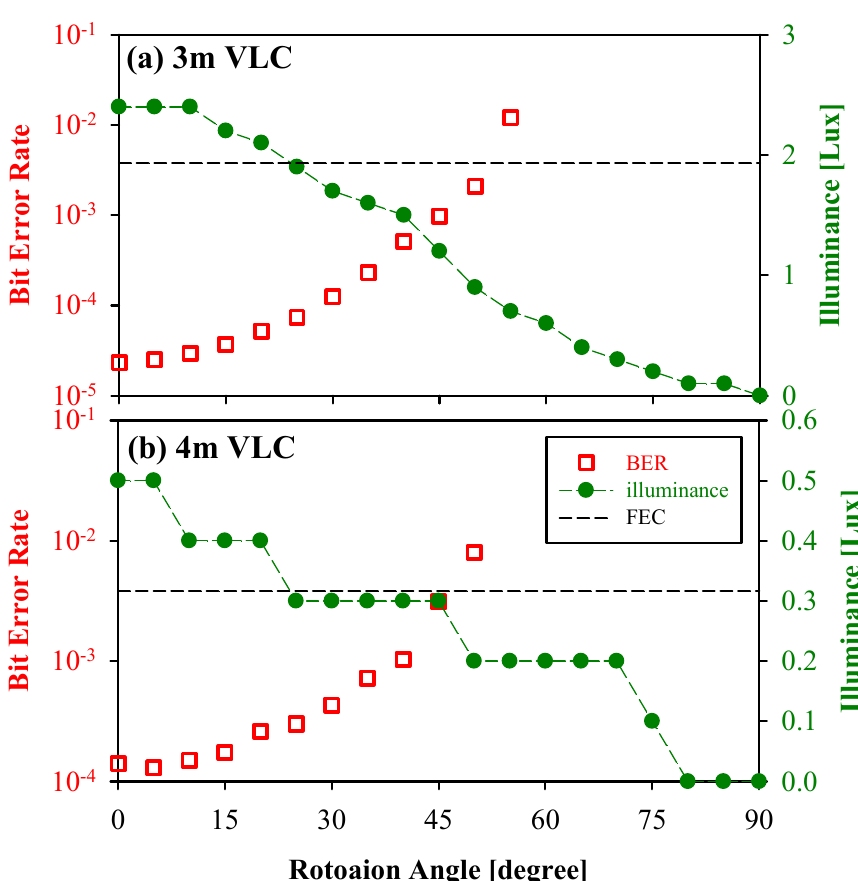
Figure 6. VLC (Green) BER measurements of 620 and 440 Mbps after the free space link of ( a ) 3 and ( b ) 4 m under different corresponding illuminance.